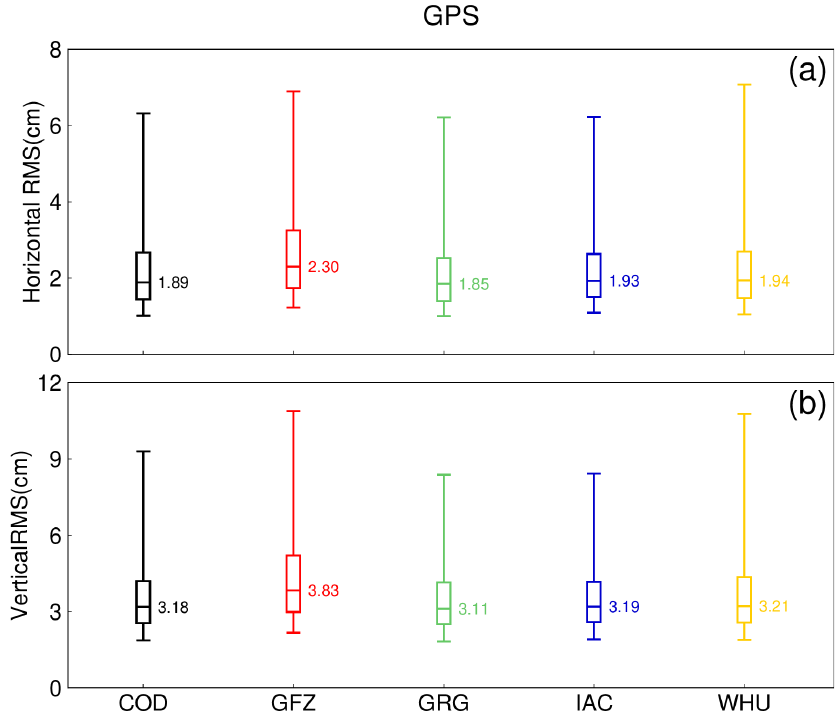
Figure 14. Distribution of the RMS of the GPS kinematic PPP solutions with five types of precise products for the 143 MGEX tracking stations in September 2022. ( a ) Horizontal component, ( b ) Vertical component.